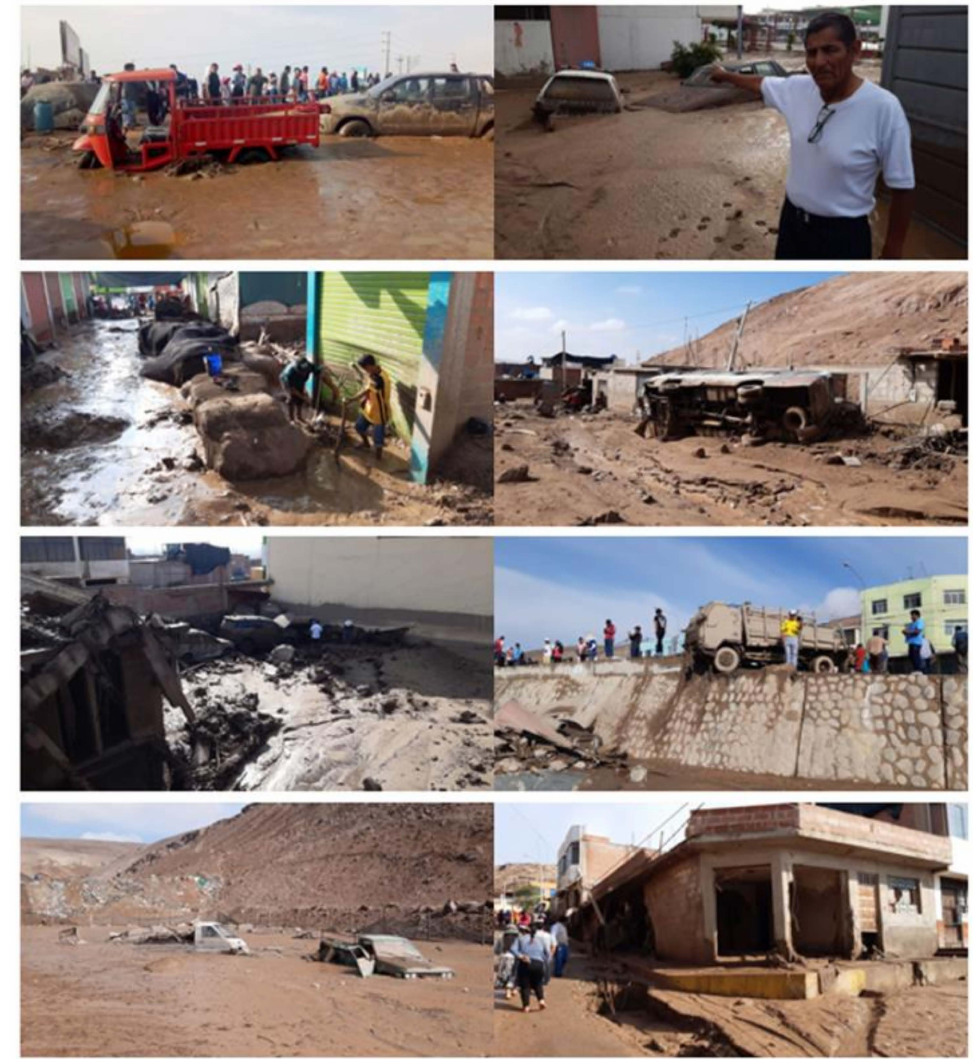
Figure 35. Gestion newspaper reports: debris flow in Tacna left three people dead, 22 February